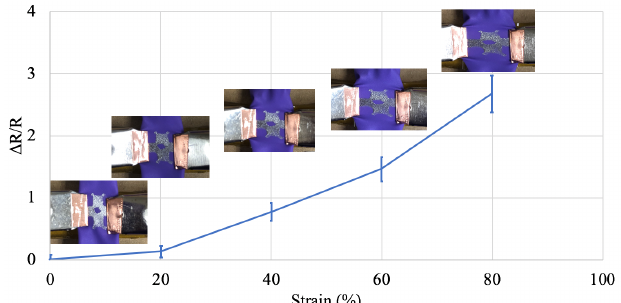
Figure 5. Change in normalized measured resistance versus uniaxial strain for a sprayed LM pattern on a stretchable nitrile surface.